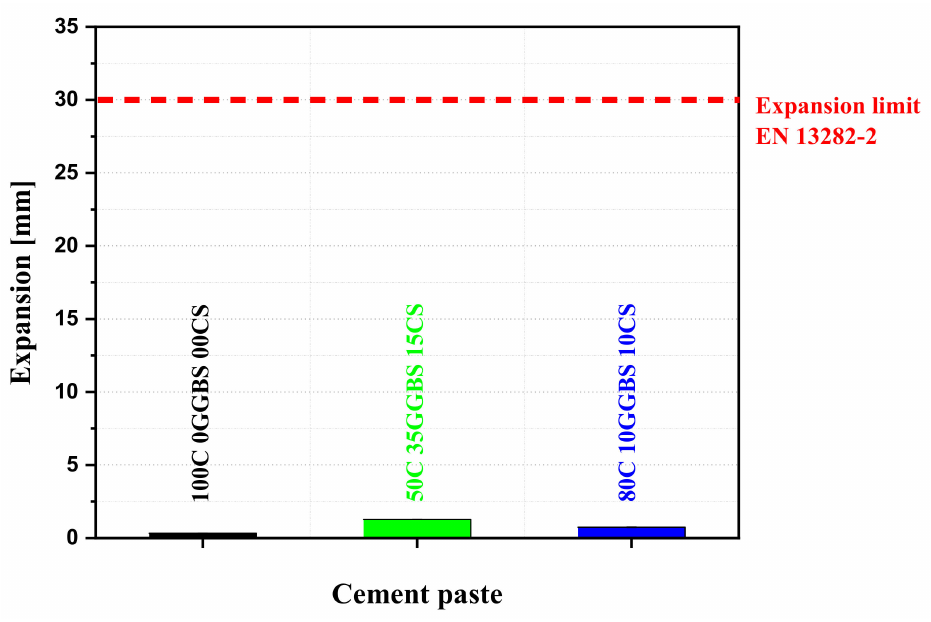
Figure 11. Cement paste expansion values.